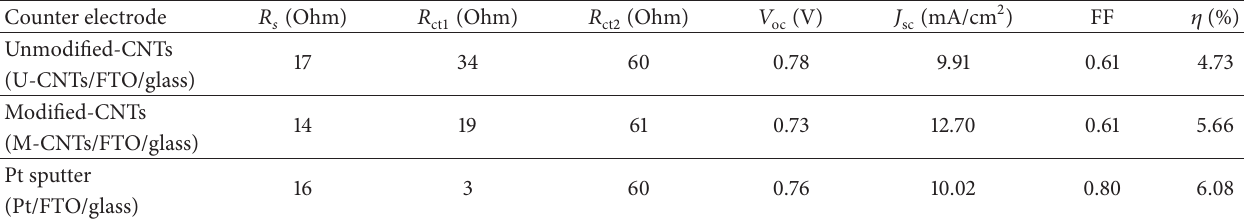
Table 2: Summary of the interface charge-transfer resistance at the CE/electrolyte interface ( 𝑅 ), the series resistance ( 𝑅 𝑠 ), open-circuit voltage ( 𝑉 ( 𝑅 ct 2 M-CNTs, and Pt glass